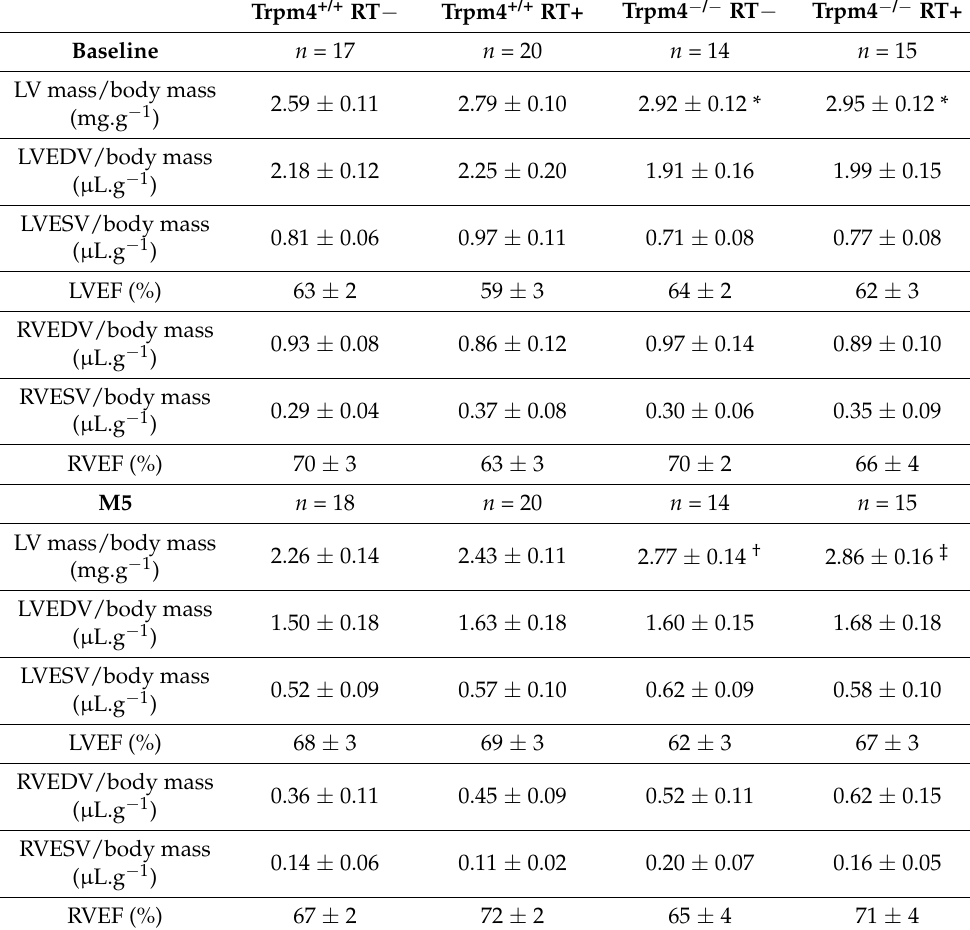
Table 2. Cardiac magnetic resonance imaging findings. CMR imaging parameters in 4-month-old mice at baseline (before irradiation) and 5 months after irradiation treatment (M5). Animals were randomly allocated to radiation treatment (RT+) or not (RT − ). Data are mean ± S.E.M. * statistically different from +/+. † statistically different from +/+ RT − . ‡ statistically different from +/+ RT+. LV: left ventricle; LVEDV: left ventricular end diastolic volume; LVESV: left ventricular end systolic volume; LVEF: left ventricular ejection fraction; RVEDV: right ventricular end diastolic volume; RVESV: right ventricular end systolic volume; RVEF: right ventricular ejection fraction. Trpm4 +/+ RT − Trpm4 +/+ RT+ Trpm4 − / − RT − Trpm4 − / − RT+ Baseline n = 17 n = 20 n = 14 n =